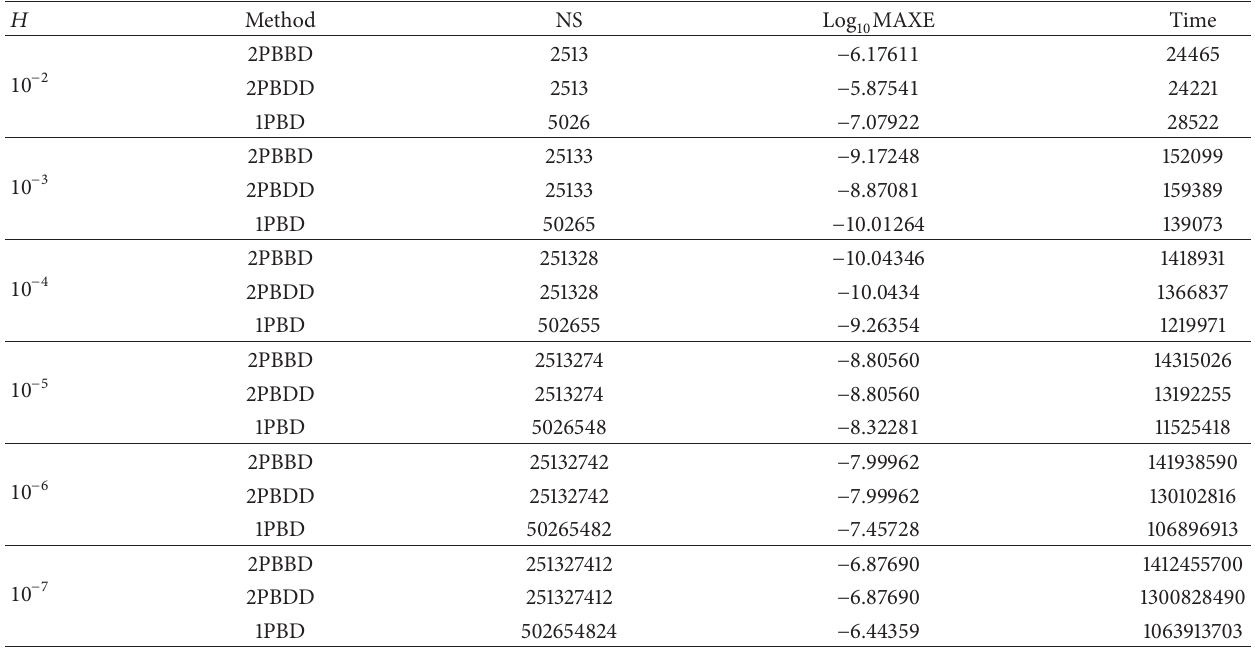
Table 6: Numerical result for Problem 3.